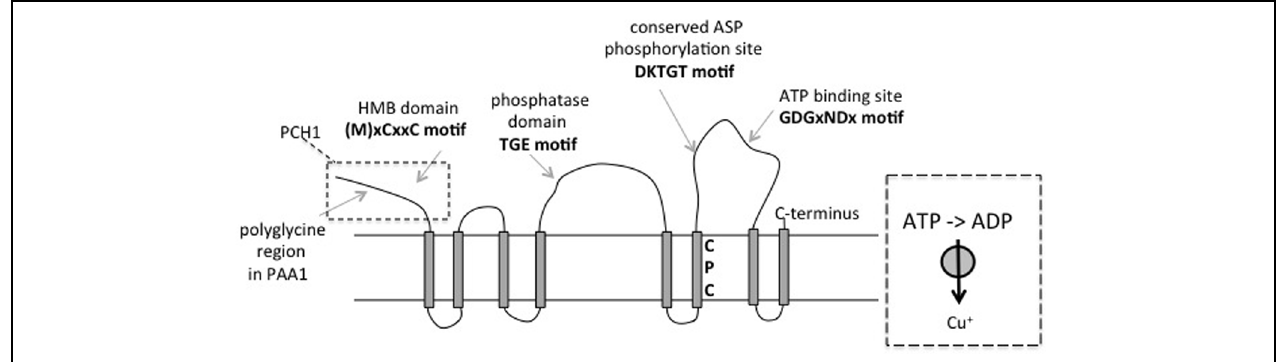
FIGURE 2 | Topology model of Cu + transporting P-type ATPases such as PAA1 and PAA2. The proteins have eight transmembrane segments. Major domains and sequence motifs are indicated. The region that corresponds to the copper chaperone PCH1, encoded in Arabidopsis by a PAA1 alternative splice form, is indicated in a box. The box on the right gives a simplified depiction of the protein in the same topology, which is used in Figure 3 also.